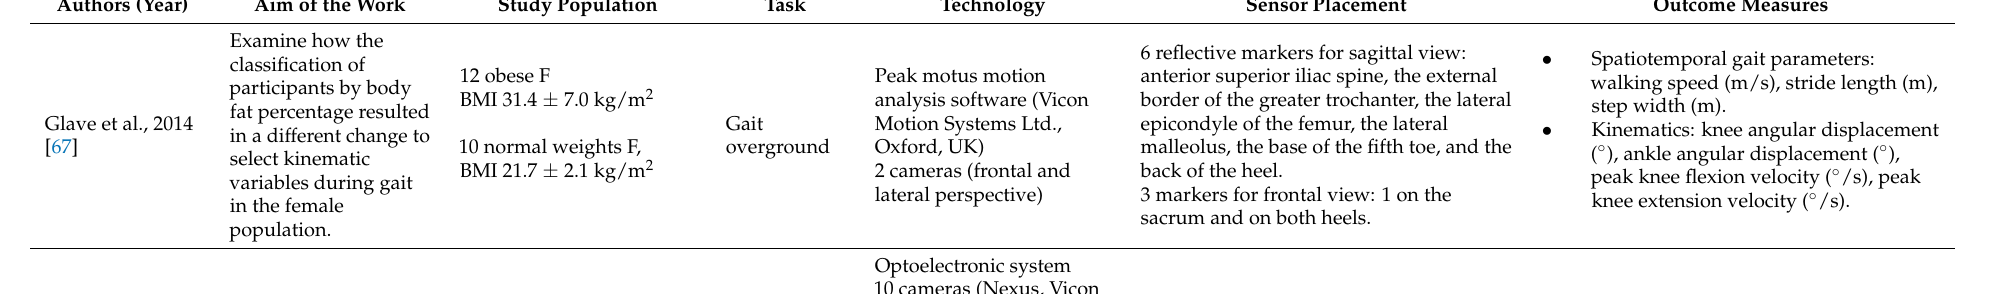
Sensor Placement 6 reflective markers for sagittal view: anterior superior iliac spine, the external border of the greater trochanter, the lateral epicondyle of the femur, the lateral malleolus, the base of the fifth toe, and the back of the heel. 3 markers for frontal view: 1 on the sacrum and on both